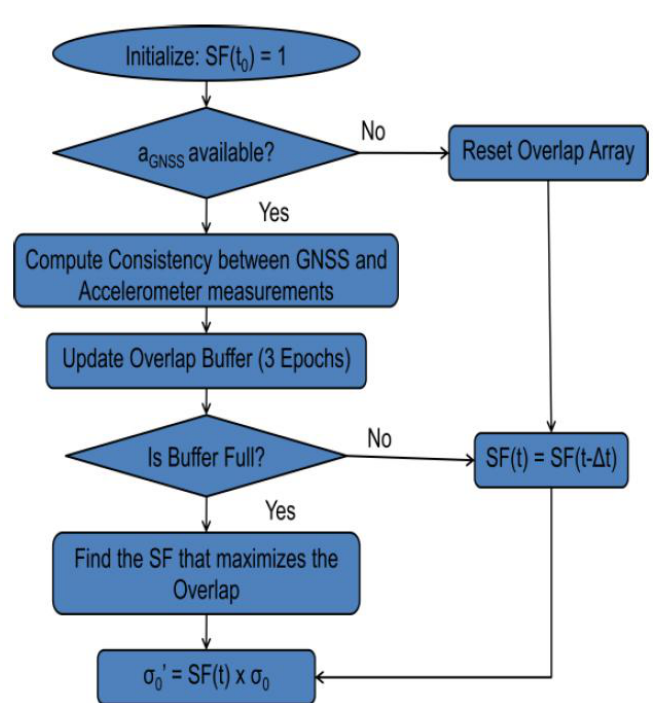
Figure 3. GNSS a priori variance